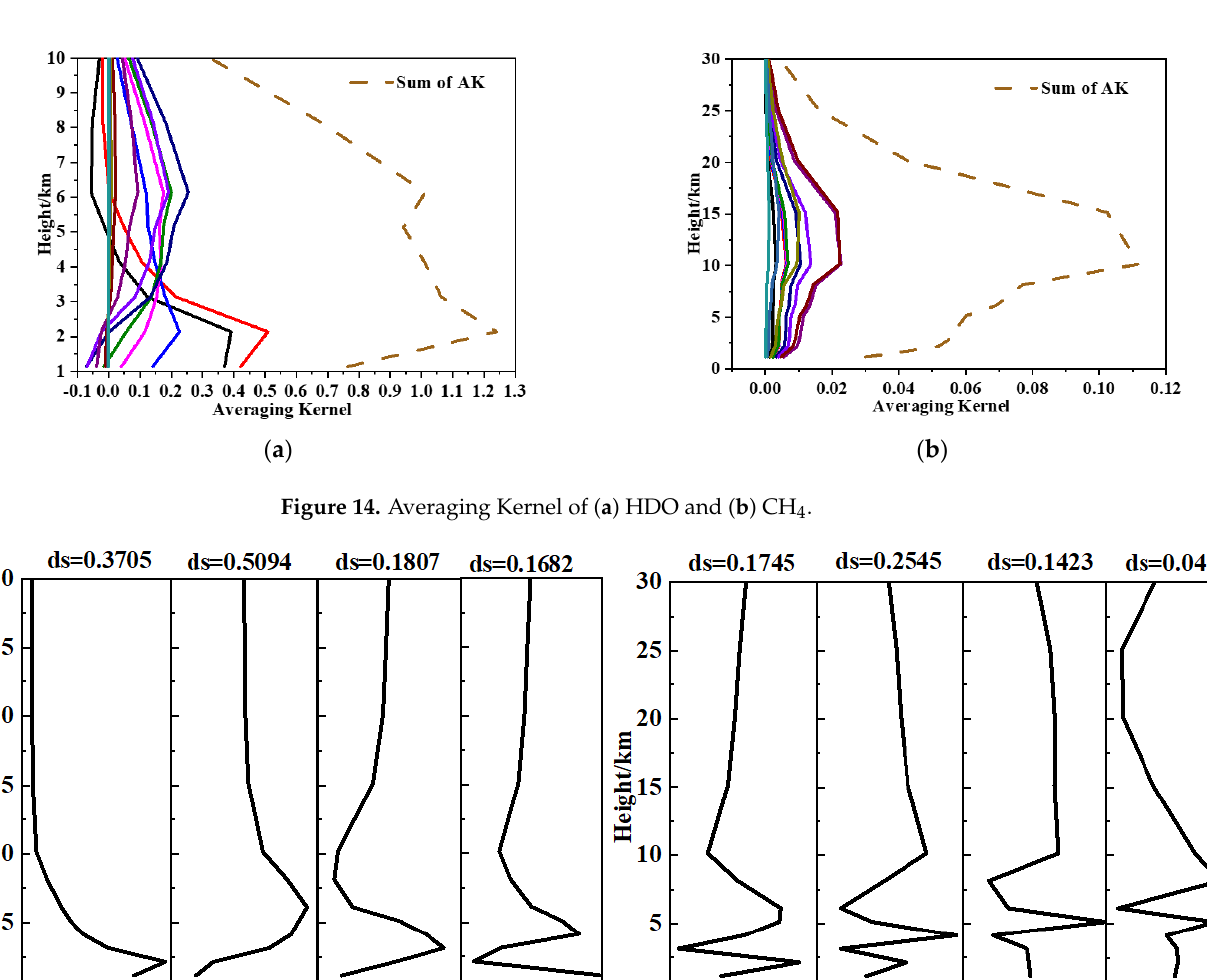
Figure 15. The first eight and most significant singular vectors (SVs) of K (cid:3561) matrix.